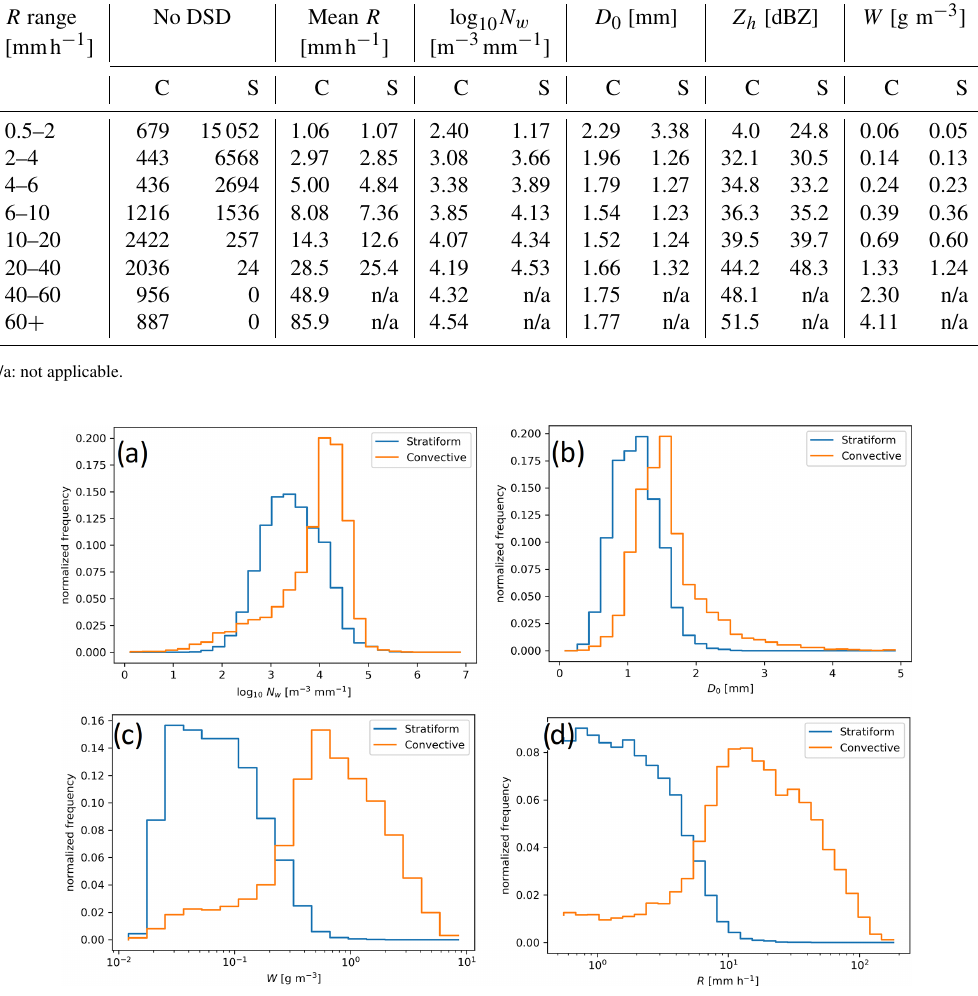
Figure 3. Normalized frequency histograms of (a) N w , (b) D 0 , (c) W , and (d) R separated by the BR09 stratiform-convective